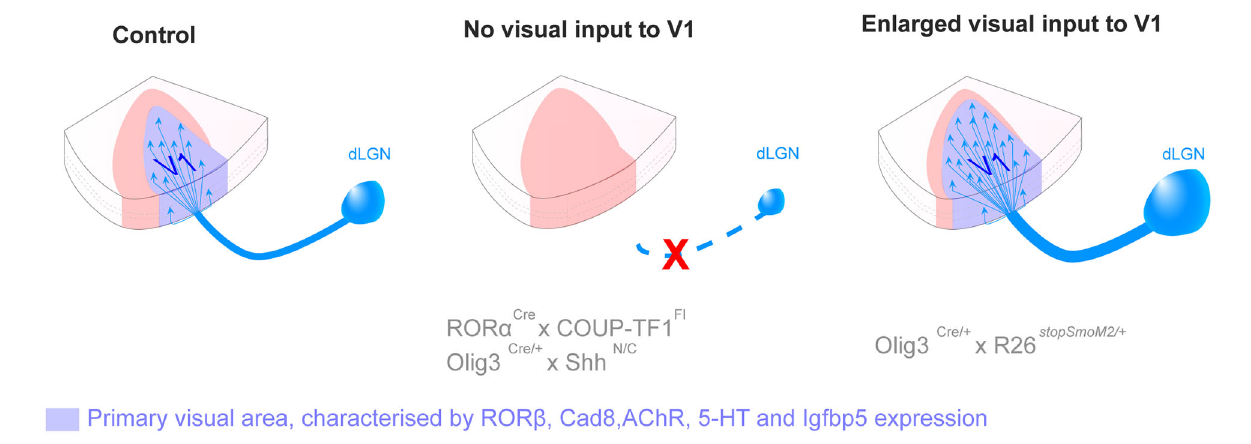
and a reduction of secondary domain. The size of the LPN, the thalamic nucleus projecting to higher order visual areas, varies in a similar manner as the size of the higher visual area, suggesting feed-back regulation. The mechanisms by which thalamic axons influence the fate of cortical neurons in not yet understood (For more details see Chou et al., 2013; Vue et al.,